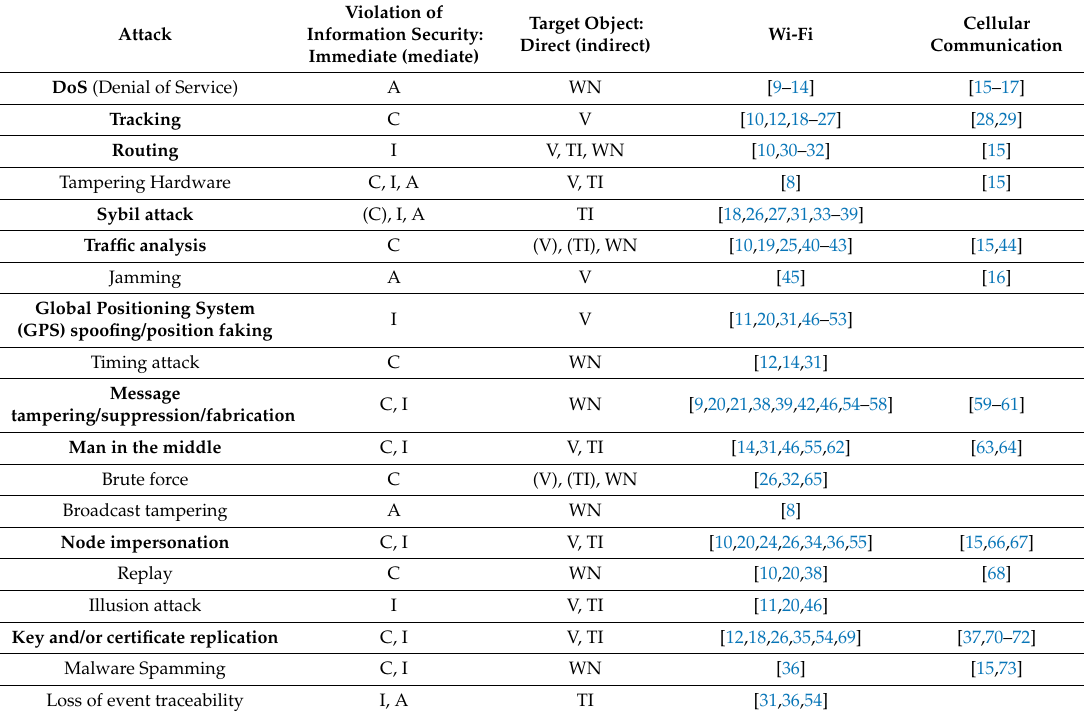
Table 1. The list of “popular“ cyber security threats to vehicle wireless